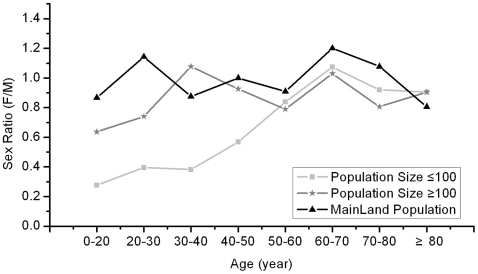
Sex ratio (F/M) of the mainland population (triangle), 3 populations with more than 100 individuals (star), and 27 populations less 100 individuals (diamond), by age class.